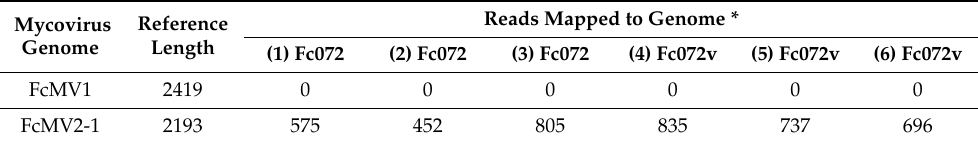
Table 4. Mapping summary statistics, with the reference genomes of mitoviruses FcMV1 and FcMV2- 1 as